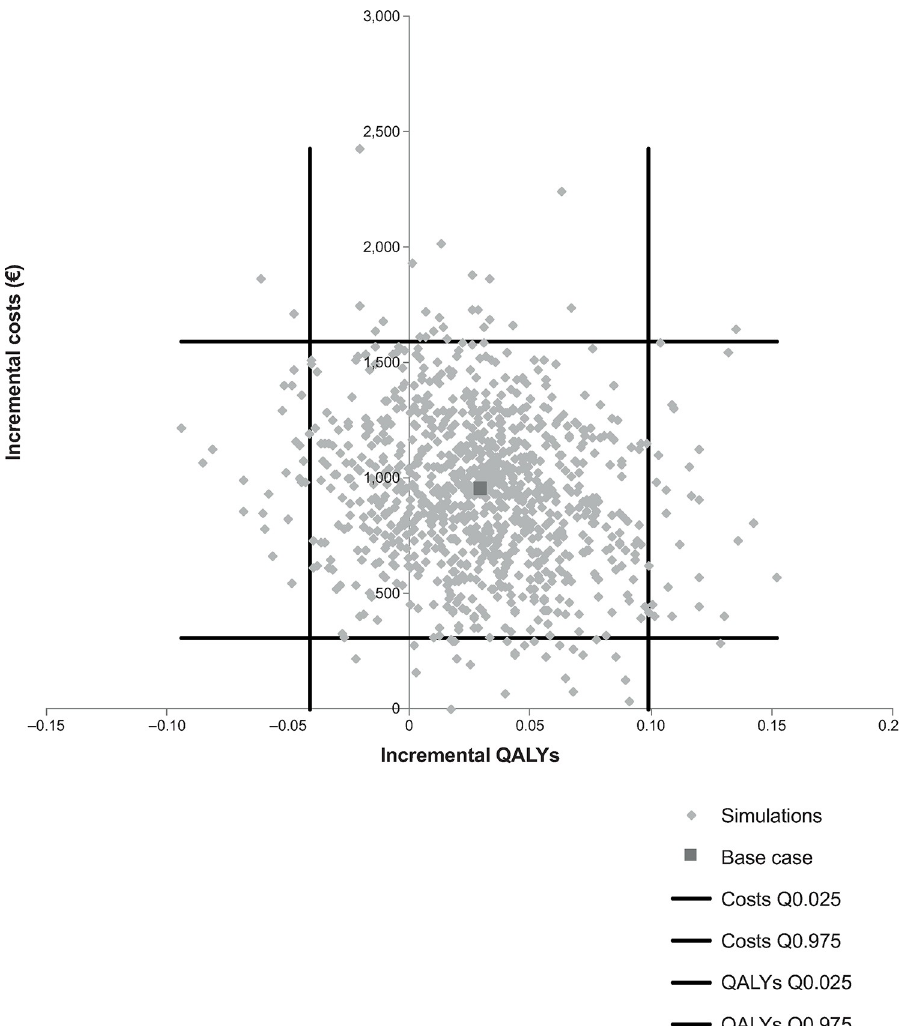
Fig 6. Apixaban incremental cost-effectiveness plane. QALY, quality adjusted life years.